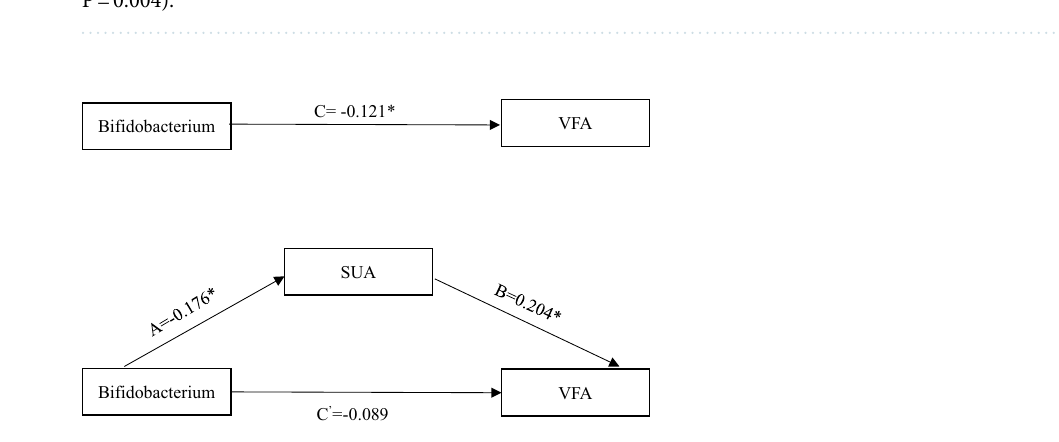
Figure 4. Proposed models that investigate mediated effects *P <